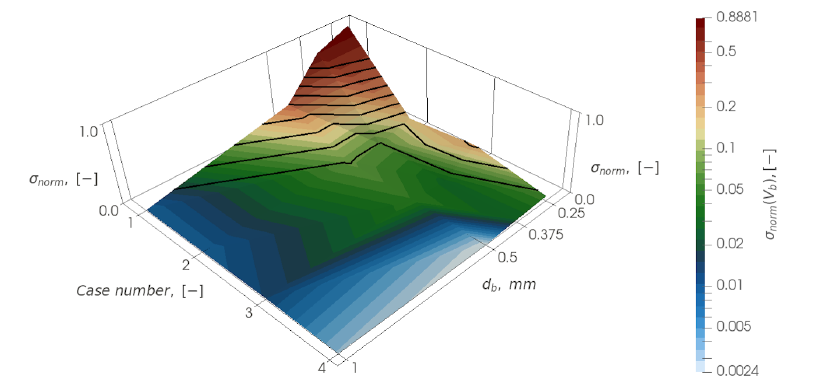
Figure 10. Distribution of a weighted variance σ norm for the bubble velocity, V b .